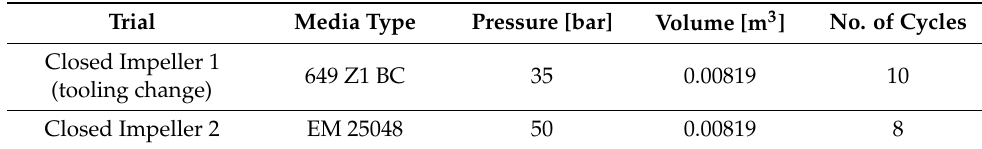
Figure 8. Illustration of the ( a ) customized tool required for performing the AFM finishing process and ( b ) the closed impeller mounted on the customized tool. Table 4. AFM process parameters. Table 4. AFM process